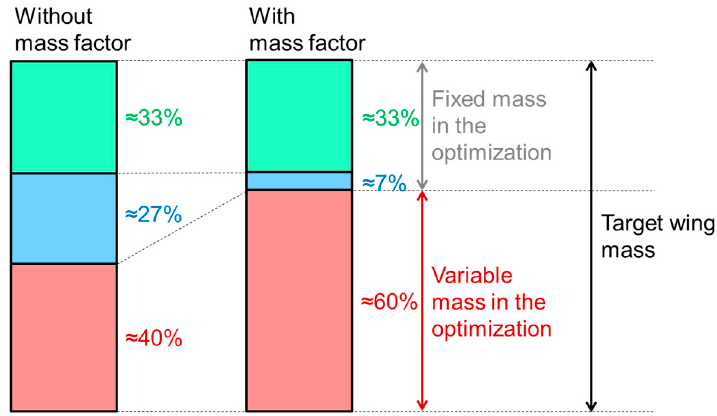
Figure 49. Increase of the fraction of variable mass with mass